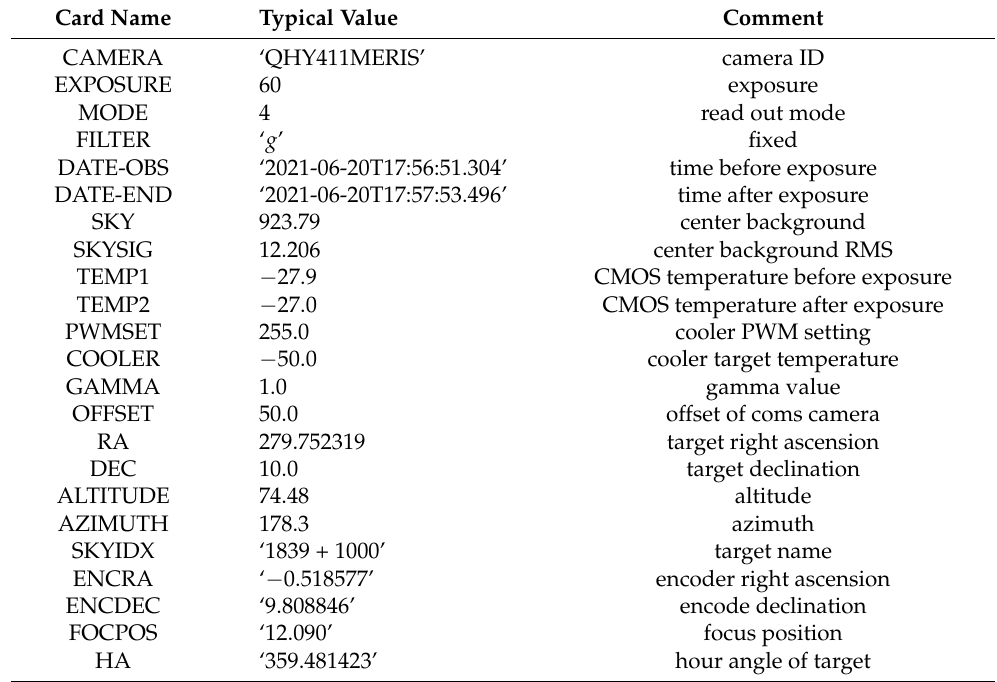
Table A2. AST3-3 Header in Observation fits